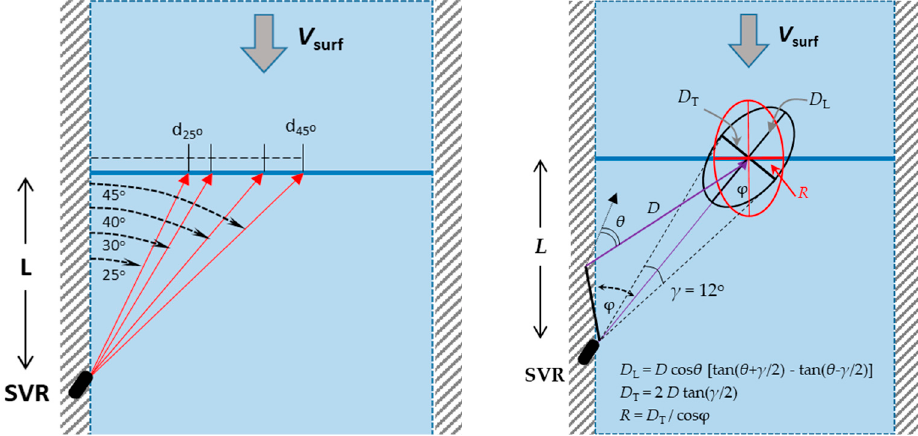
Figure 2. Geometry of measurements: V surf is the surface velocity; θ is the pitch-down angle; φ is the yaw angle; γ is the nominal horizontal beam width; D is the distance between the radar and the water surface in the line of-sight direction; D L the longitudinal and D T the transversal diameters of the ellipse conic; R is the beam footprint on the cross-section; L is the distance of the SVR from the cross section, d φ is the distance between the centroid of the beam footprint on the cross-section and the bank ( d 45° = L ).